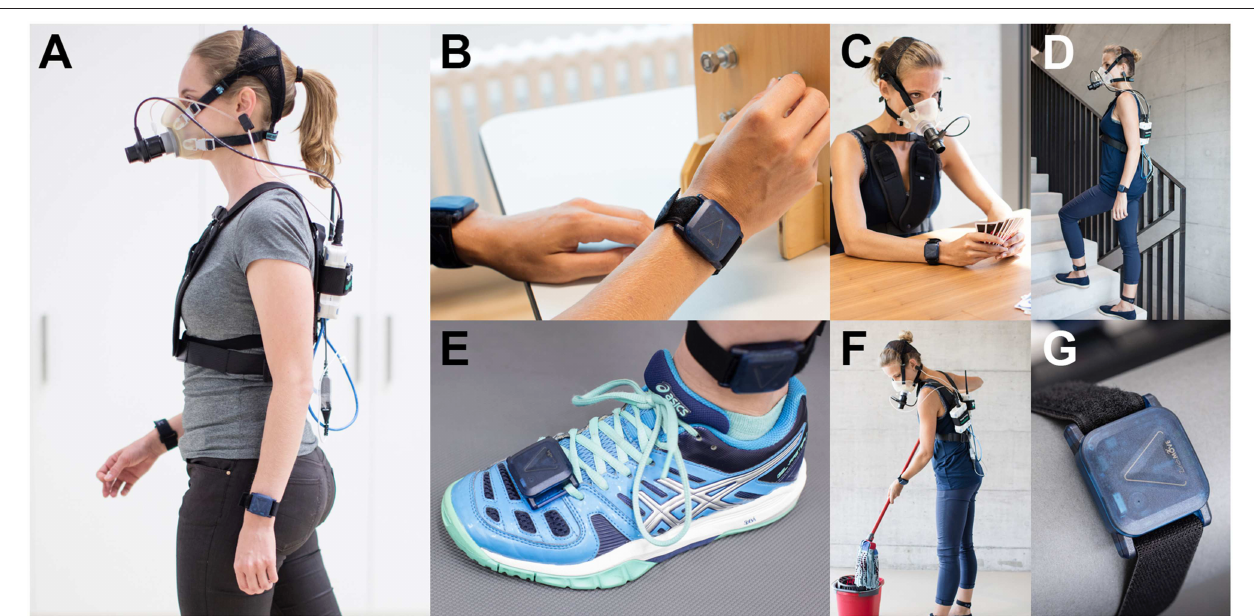
FIGURE 1 | Examiners equipped with the full measurement setup, i.e., eight JUMP modules and the indirect calorimeter. (A) Side view of an examiner during the activity walking with two JUMP modules attached at each wrist and the indirect calorimeter with the facemask (with a turbine), data exchange unit, and the sensor box. Note, that the JUMP modules placed at the chest and the hip are not visible (usually hidden under the shirt). (B) Extract from the GRASSP assessment during the prehension part. (C) Examiner wearing the experimental setup during the activity playing cards and (D) climbing stairs. (E) Close view of the JUMP modules fixed at the foot and at the ankle. (F) Examiner during the activity sweeping a mop. (G) Close view of the JUMP module recently developed by the ZurichMOVE consortium. Written and informed consent was obtained for the publication of these